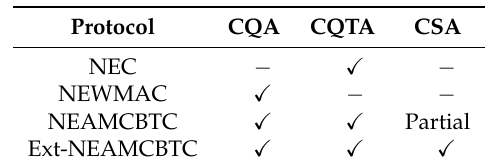
Table 7. Feasibility of the proposed schemes for stream-based communication in multichannel WSNs. CQA, Channel Quality Assessment; CQTA, channel quality-tracking assessment; CSA, channel stability